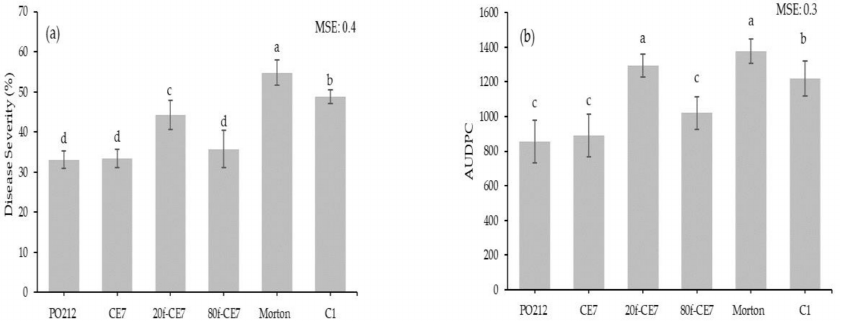
Figure 3. Activity of freezing of Penicillium rubens strain 212 (PO212) crude extract (CE7) at − 20 ◦